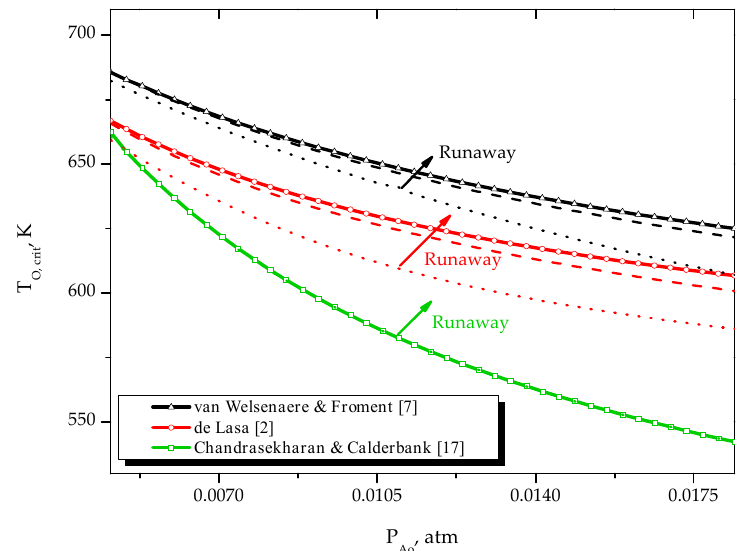
Figure 5. Runaway diagram for the o-xylene oxidation as relation of inlet o-xylene partial pressure and temperature. Curves obtained for three kinetic models of different complexity: (i) One reaction, as used by van Welsenaere and Froment [7]; (ii) Three reactions, as used by de Lasa [2]; and (iii) Five reactions, as proposed by Chandrasekharan and Calderbank [17]. Cooling flow pattern: constant cooling temperature (-), co-current direction (- -) and countercurrent direction (· ·).